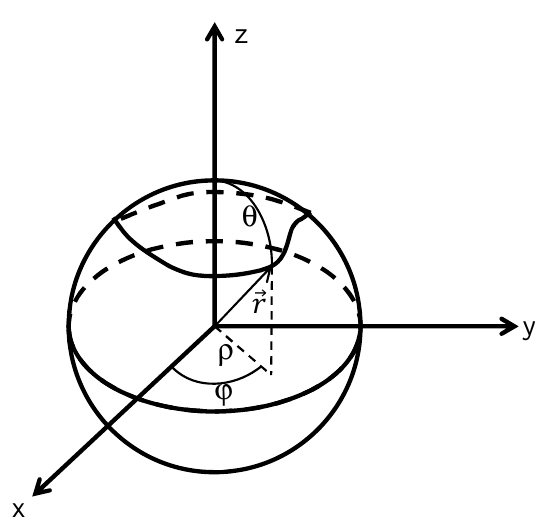
Figure A1. Geometry of a polar cap delineated using a Fourier se- ries, represented in polar